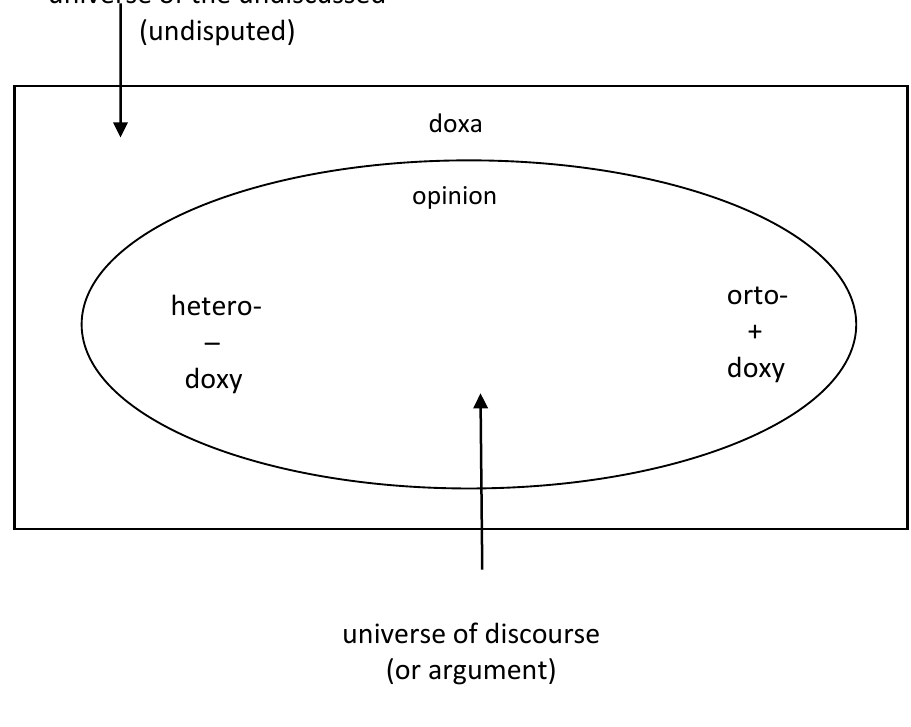
Figure 1: The relationship between heterodoxy, orthodoxy and doxa (Bourdieu, 1977, p.